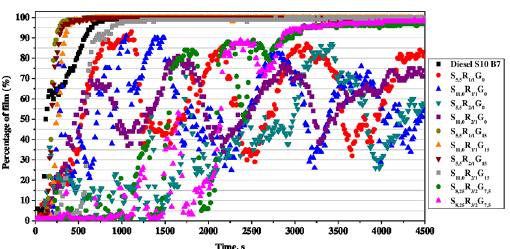
Figure 3. Percentage of lubricating film formation on the disc surface.